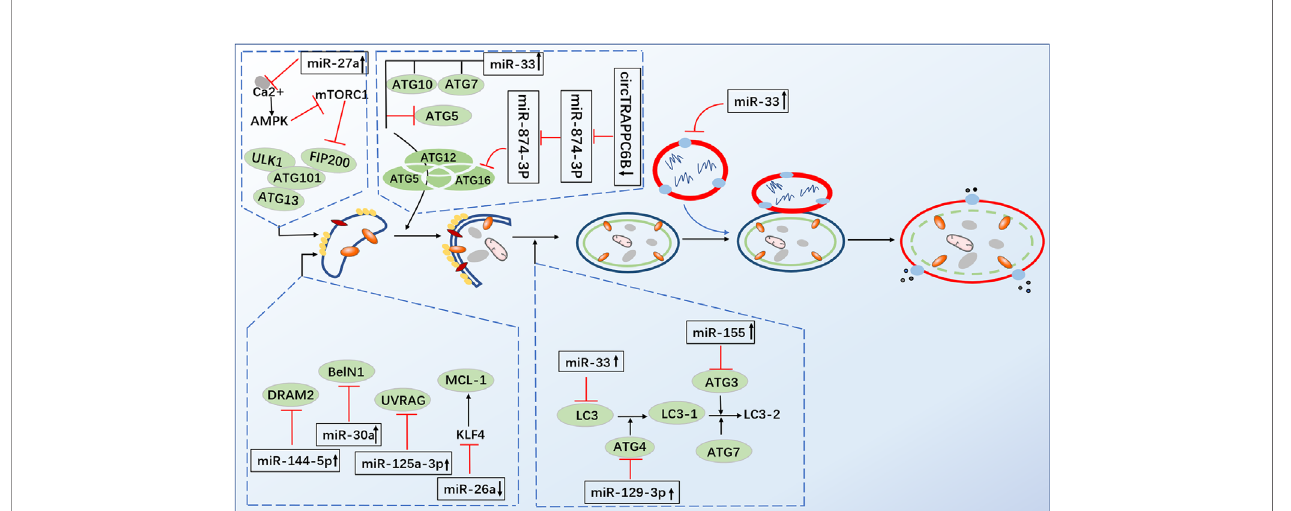
FIGURE 3 | Infection by M. tuberculosis leads to alterations of miRNA expression in host cells, which regulate multiple steps of autophagy. MiR-26a facilitates upregulation of the KLF4, that favor the increased expression of Mcl-1 which in turn inhibits autophagosome formation miRNA-17-5p inhibits autophagy by inhibiting Mcl-1 and by binding to Beclin-1 to targe Mcl-1. MiR-33 inhibit autophagic fl ux by targeting lysosomal pathway transcription factors (FOXO3 and TFEB), activators (AMPK) and multiple effectors (ATG5, ATG12, LC3B and LAMP1). MiR-30a, miR-125a-3p and miR-144-5p respectively targeting Beclin-1, UVRAG and DRAM2. MiR-129-3p inhibit phagosome formation by targeting Atg4b. MiR-27a directly targets the Ca 2+ transporter Cacna2d3 to inhibit autophagy. CircTRAPPC6B antagonized the ability of miR-874-3p to inhibit ATG16L1 expression, thereby activating and increasing autophagy. Direct stimulatory modi fi cation; Direct inhibitory modi fi cation; Tentative stimulatory modi fi cation; Tentative inhibitory modi fi